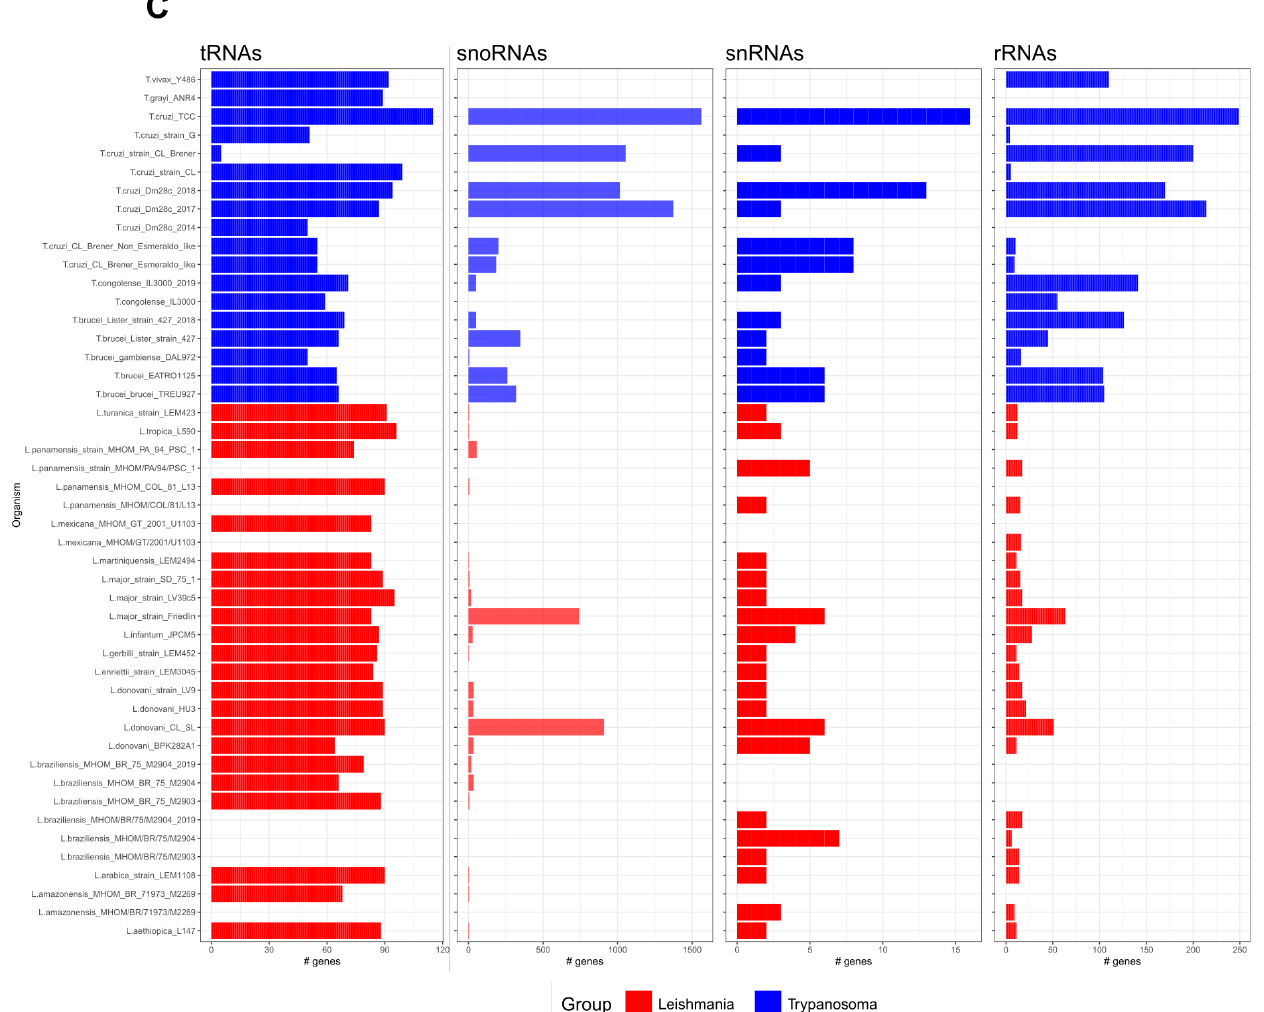
Figure 1. Outlook of the non-coding genomic annotations available in TriTrypDB. All Leishmania spp. and Trypanosoma spp. genomic data was obtained from TritrypDB (Release 56) for protein-coding genes ( A ) and non-protein-coding genes ( B ). The inset plot presents the distribution of the number of genes annotated for all genomes grouped by reference and non-reference strains. For the main ncRNAs biotypes (tRNAs, snoRNAs, snRNAs, and rRNAs) the number of features annotated is presented in bar plots ( C ) for all genomes with a least 1 ncRNA annotation. Arrows point out species with large numbers of genome strains